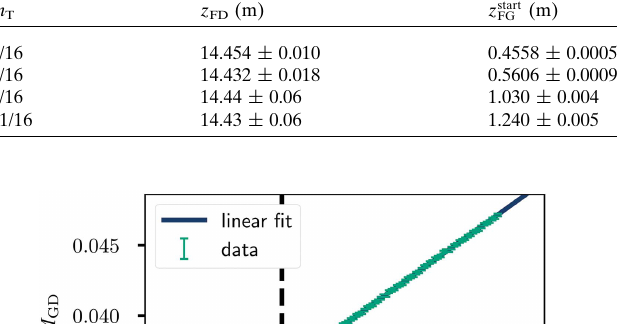
obtained from the fits to the GD